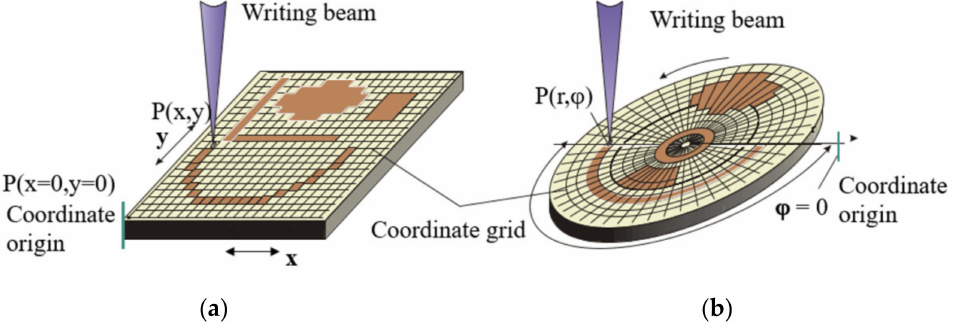
Figure 1. Scanning of writing beam and writing of arbitrary pattern by X-Y SLLS ( a ) and CLWS ( b